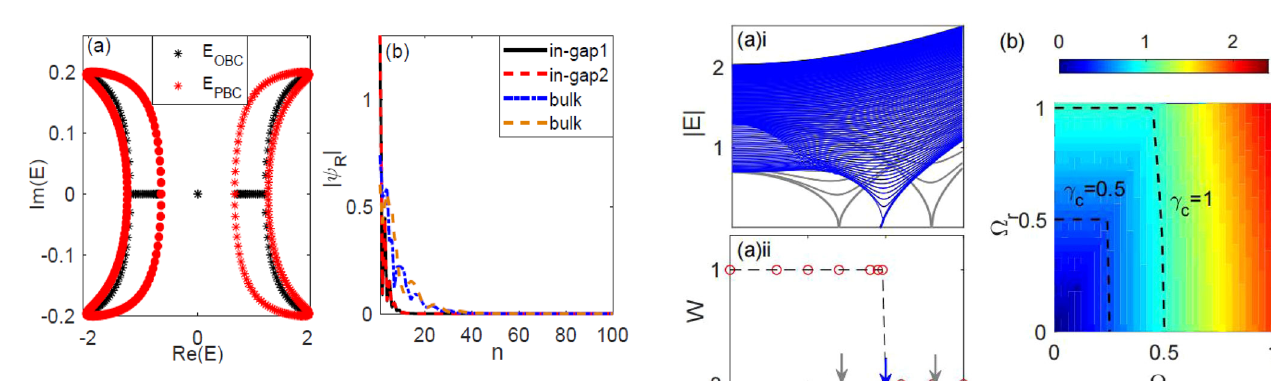
Fig. 3 Coexistence of non-Hermitian skin effect and band topology for case-III with ϕ r = π , ϕ 0 = π /2, and Ω 0 = 0.5, Ω r = 0.3, γ = 0.2. a Energy spectra under periodic boundary condition and open boundary condition in the complex plane. b Spatial wave functions for the two topological edge modes and two randomly chosen bulk states. Here the energy unit is taken as hopping t .